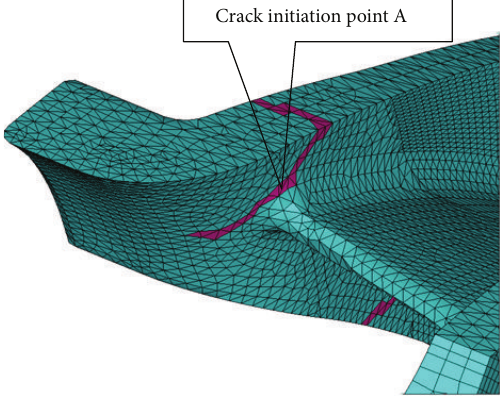
Figure 11: Initial crack direction of the impeller (𝑛𝑚 = 500) .